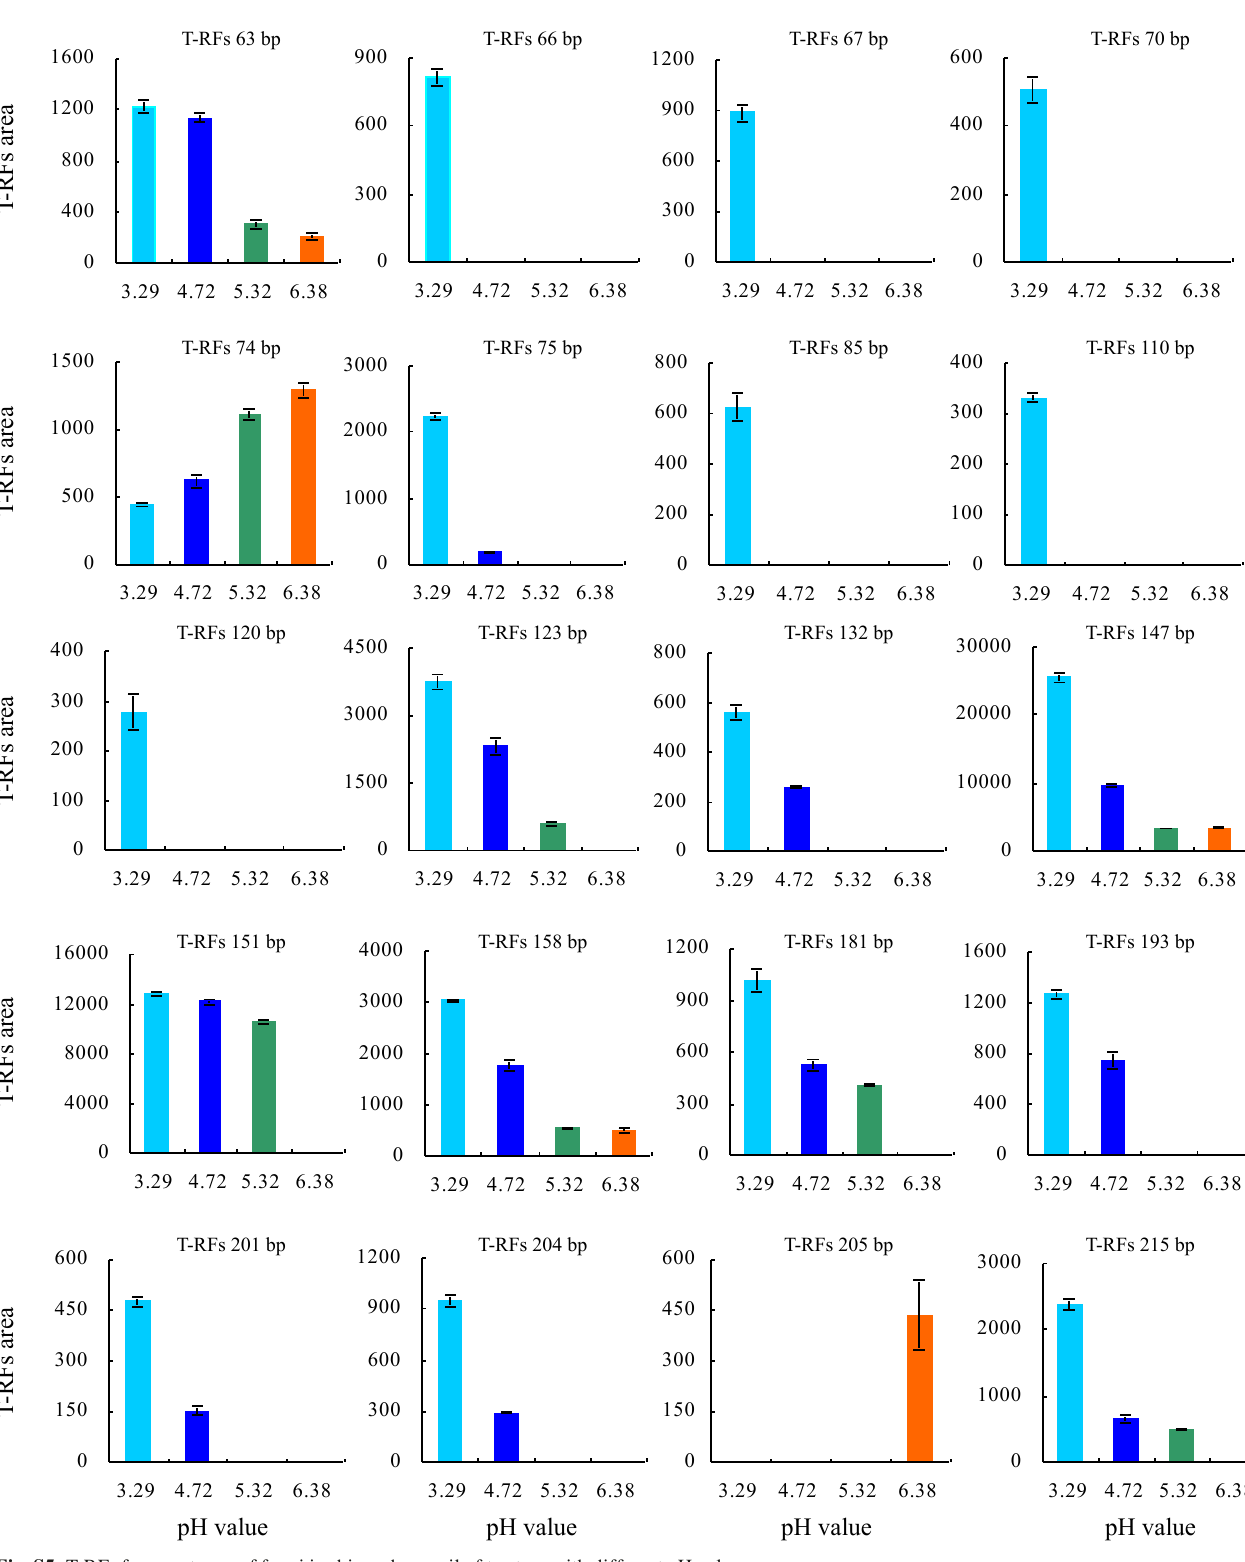
Fig. S5: T-RFs fragment area of fungi in rhizosphere soil of tea tree with different pH